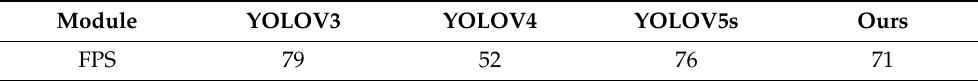
Table 2. Detection speed of each model on the underwater